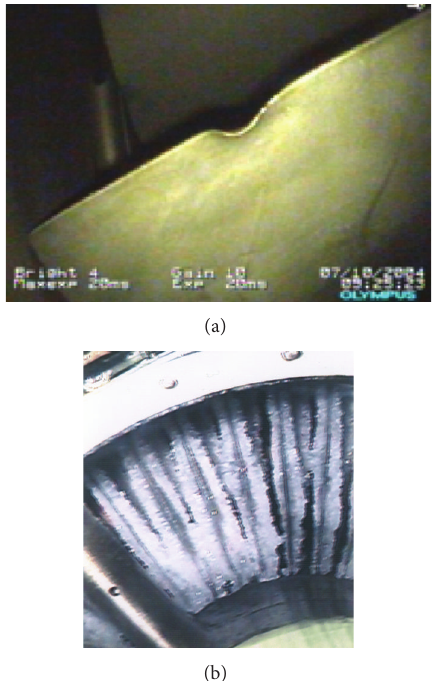
Figure 7: Showing LCF concentrations: (a) blade with FOD; (b) icing of compressor inlet.